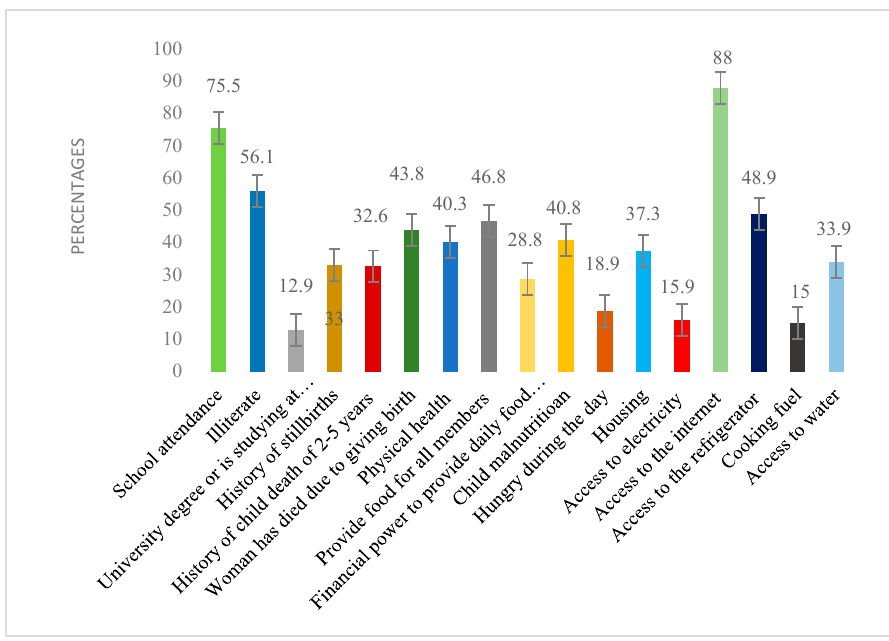
Figure 5. The intensity of poverty (A) in rural households (in percent).